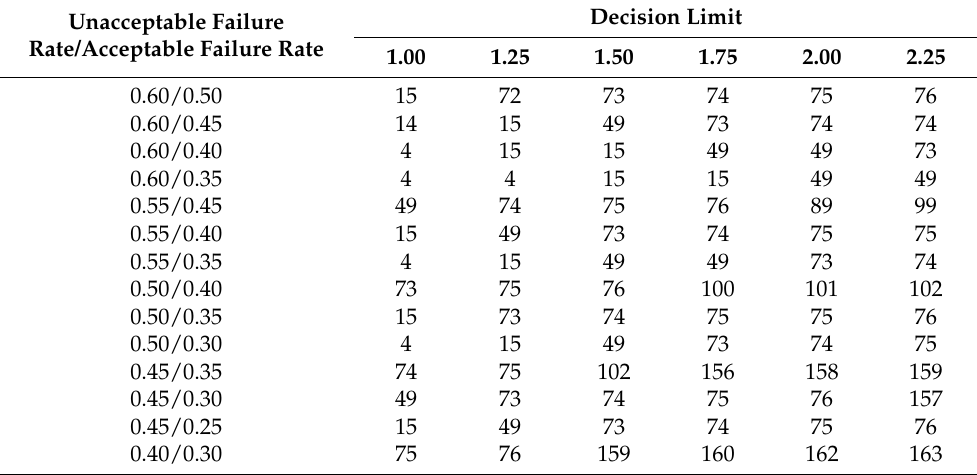
Table 3. Sensitivity analysis using various cutoff